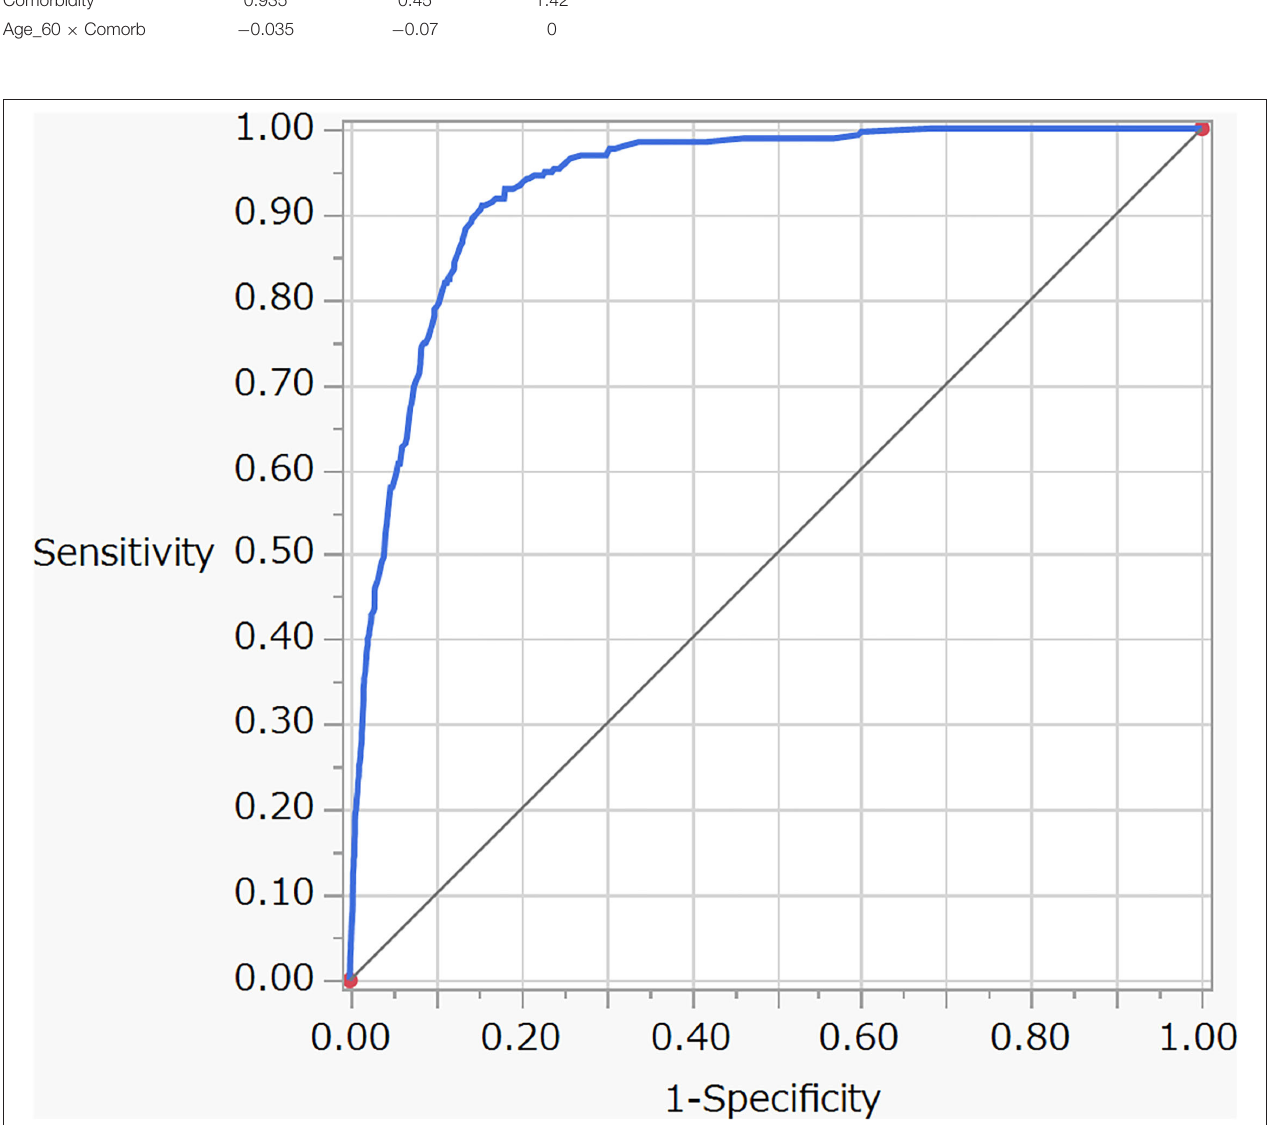
FIGURE 4 | Receiver operating characteristic (ROC) curve for the logistic model described in Table 8 .